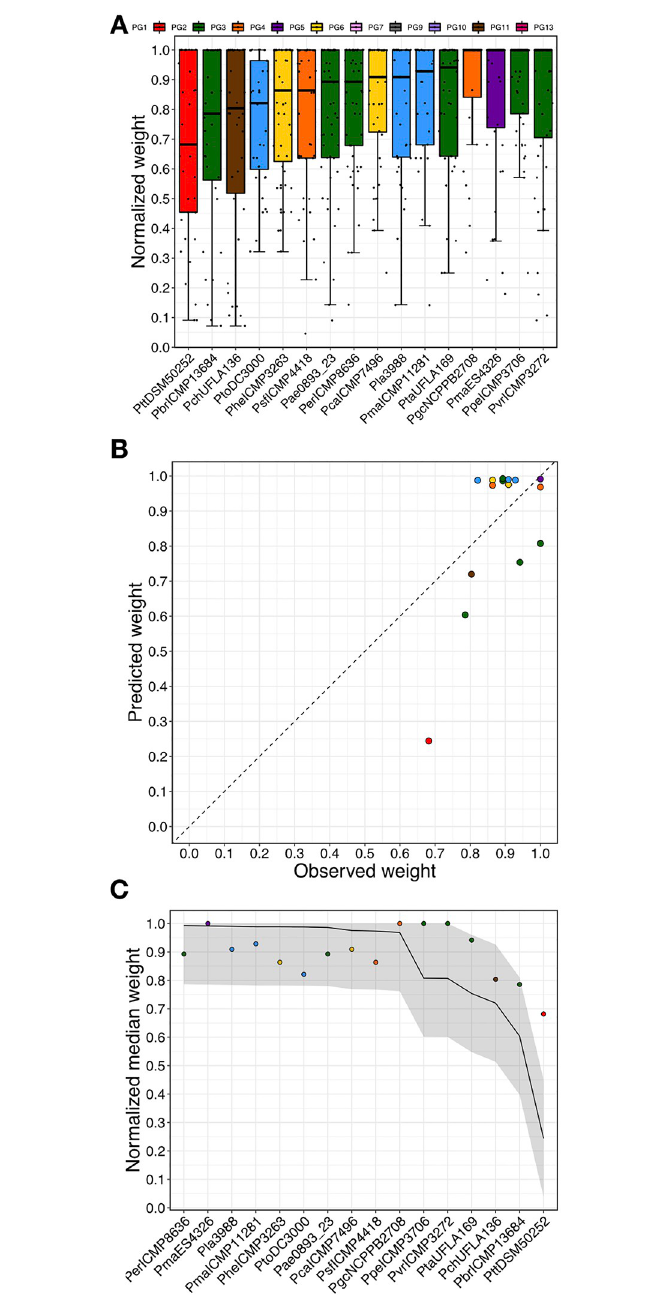
Fig 9. Correlation between predicted and observed weights of plants infected with isolates previously unseen by the model. (A) Normalized weight distribution of 16 isolates previously unseen by the model (not clonally related to any screened strain, i.e., having a core genome evolutionary distance > 0.001 and a T3SE Jaccard similarity of < 0.8 compared to the screened strains). (B) Predicted virulence as a function of observed virulence on seed infected bean plants. Color coding indicates PGs. Dashed line indicates 1:1 relationship. (C) Virulence for each isolate tested ordered by predicted virulence and colored by PG. The solid line represents virulence predictions for each isolate. The grey box represents the error margins for the predictions based on the MAE and RMSE values for the